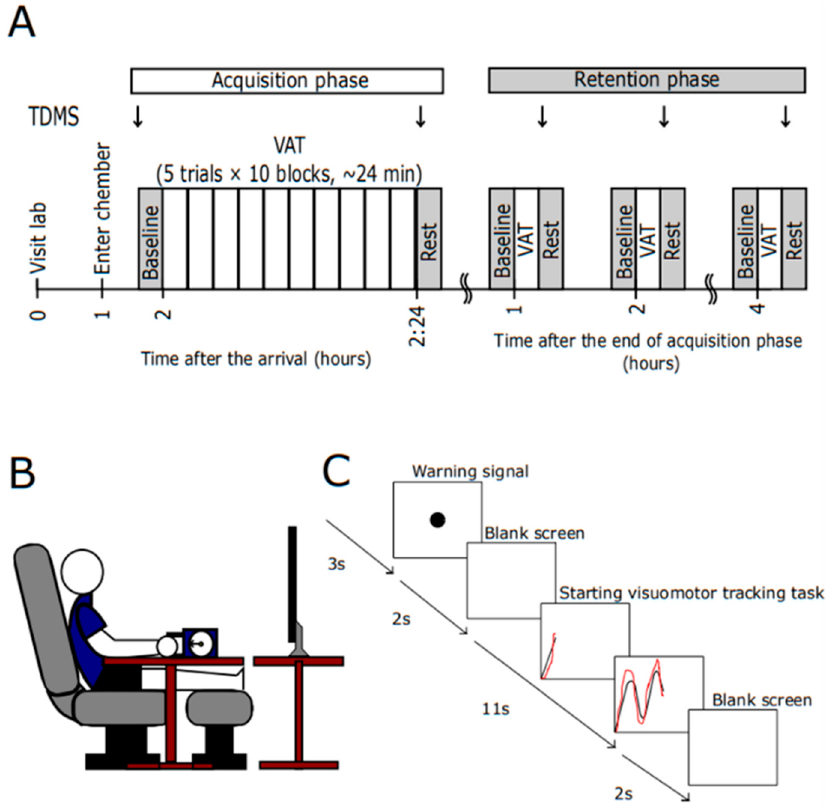
Figure 1. Experimental procedure ( A ), experimental setting ( B ), and a paradigm of a visuomotor accuracy tracking (VAT) trial ( C ) in the present study. TDMS: two ‐ dimensional mood scale.